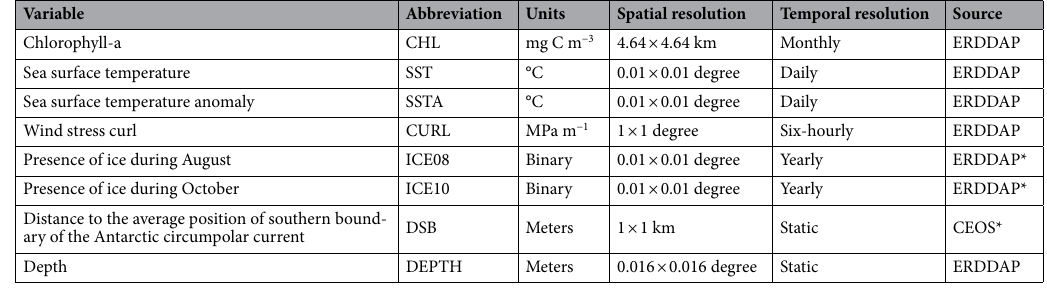
Table 2. Variables used in movement models. Asterisks denote data modification after gathering from source (see